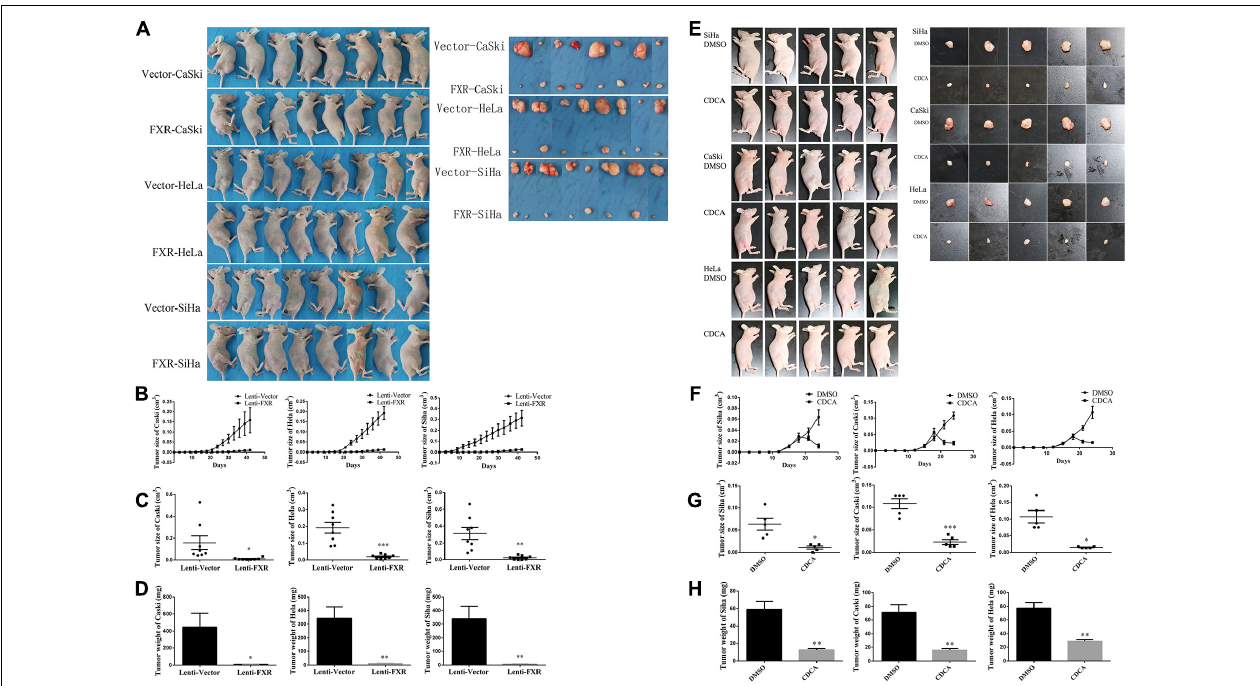
FIGURE 3 | FXR inhibits xenograft tumor formation in cervical cancer cells. (A) Female nude mice were injected Vector-CaSki/HeLa/SiHa and FXR-CaSki/HeLa/SiHa cells ( n = 8). Tumor growth was significantly inhibited by FXR overexpression, as measured by tumor growth (B) , volume (C) , and weight (D) at 42 days after injection. ∗ P < 0.05; ∗∗ P < 0.01; ∗∗∗ P < 0.001 vs. Lenti-Vector group. (E) Female nude mice were injected with SiHa, CaSki, or HeLa cells ( n = 5). Tumor growth was significantly inhibited by FXR activation by CDCA, as measured by tumor growth (F) , size (G) , and weight (H) . ∗ P < 0.05; ∗∗ P < 0.01; ∗∗∗ P < 0.001 vs. DMSO